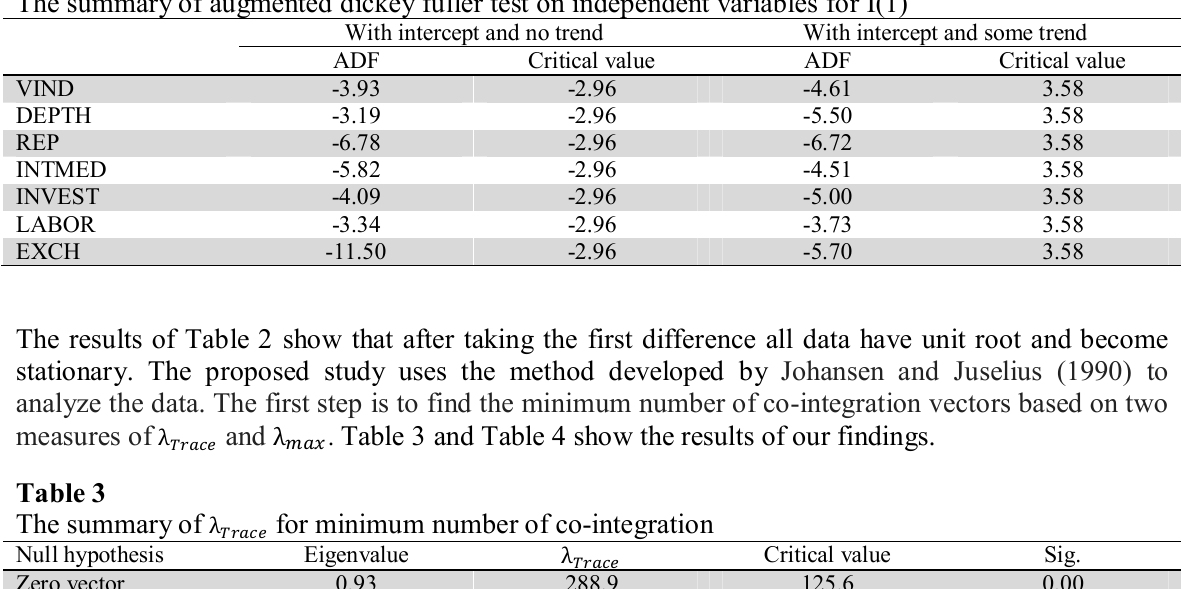
The summary of augmented dickey fuller test on independent variables for I(1) With intercept and no trend With intercept and some trend ADF Critical value ADF Critical value VIND